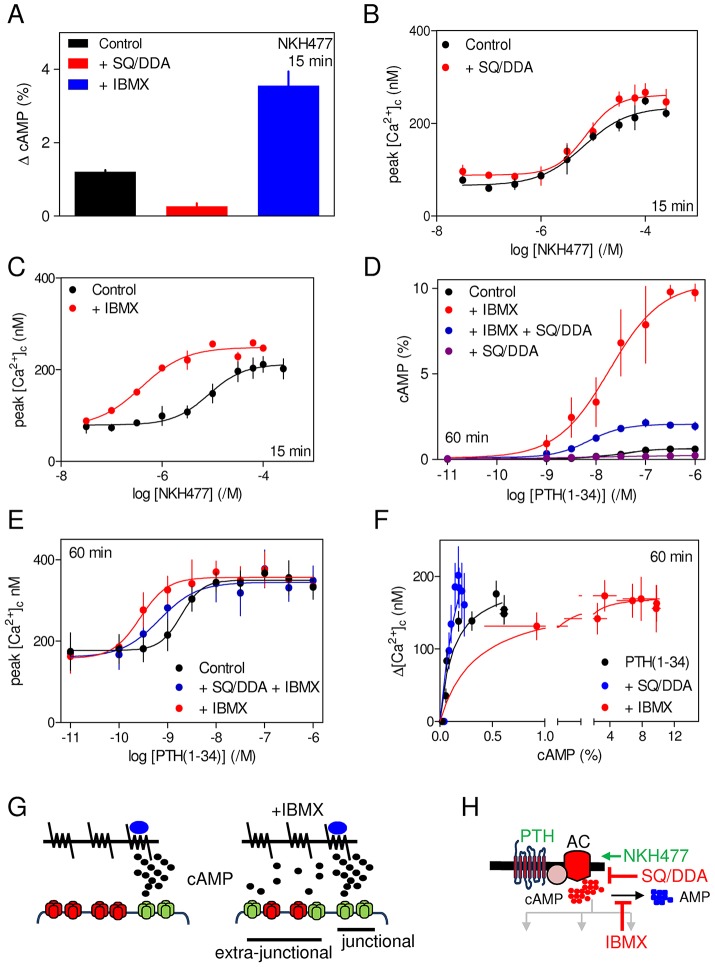
Sustained potentiation of carbachol-evoked Ca2+ signals is mediated by cAMP junctions. (A) Effects of SQ/DDA and IBMX (concentrations as in Fig. 7C) on the increase in intracellular cAMP concentration evoked by NKH477 (300 µM, 15 min). (B,C) Effects of the same treatments on the peak Ca2+ signals evoked by carbachol (20 µM) after incubation for 15 min with the indicated concentrations of NKH477. (D,E) Similar analyses of the effects of SQ/DDA and/or IBMX on the increase in intracellular cAMP concentration evoked by incubation with the indicated concentrations of PTH(1-34) for 60 min (D) or the peak Ca2+ signals evoked by carbachol (20 µM) added 60 min after PTH(1-34) (E). Results in A–E are mean±s.e.m., n = 3. (F) Relationships between cAMP and Δ[Ca2+]c for cells stimulated with PTH(1-34) for 60 min alone or after treatment with SQ/DDA or IBMX (mean±s.e.m., n = 3). (G) Normally cAMP is delivered to IP3R within signalling junctions (left panel), but the massive accumulation of cAMP during sustained stimulation with PTH and IBMX (right panel) achieves global cytosolic cAMP concentrations sufficient to sensitize IP3Rs beyond active junctions. (H) Targets of the drugs used. AC, adenylyl cyclase.